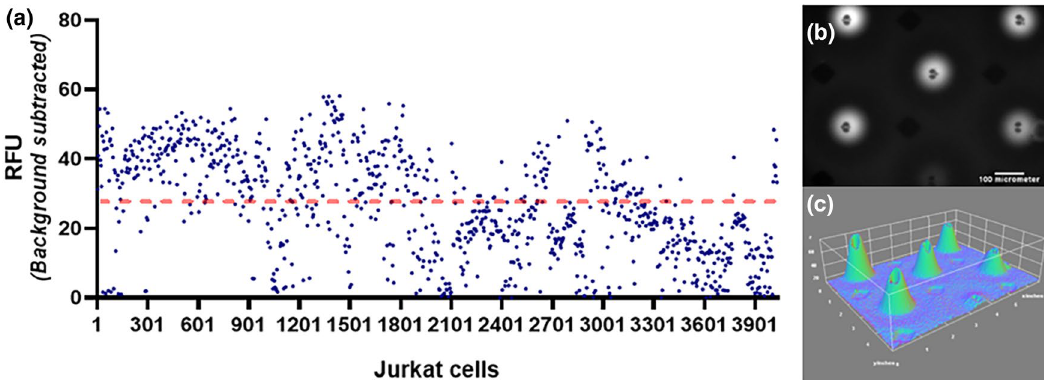
Figure 6. Single cell fluorometric granzyme B activity assay for jurkat cells ( a ) graph showing cell expression profile (dashed line indicates the mean value) ( b ) monochrome image of the microchambers showing the fluorescence (white) from AFC fluorophore ( c ) 3D surface plot of the same microchambers using ImageJ software. Graph 6a was created using GraphPad Prism 8.4.3. and 3D Plot 6c using ImageJ